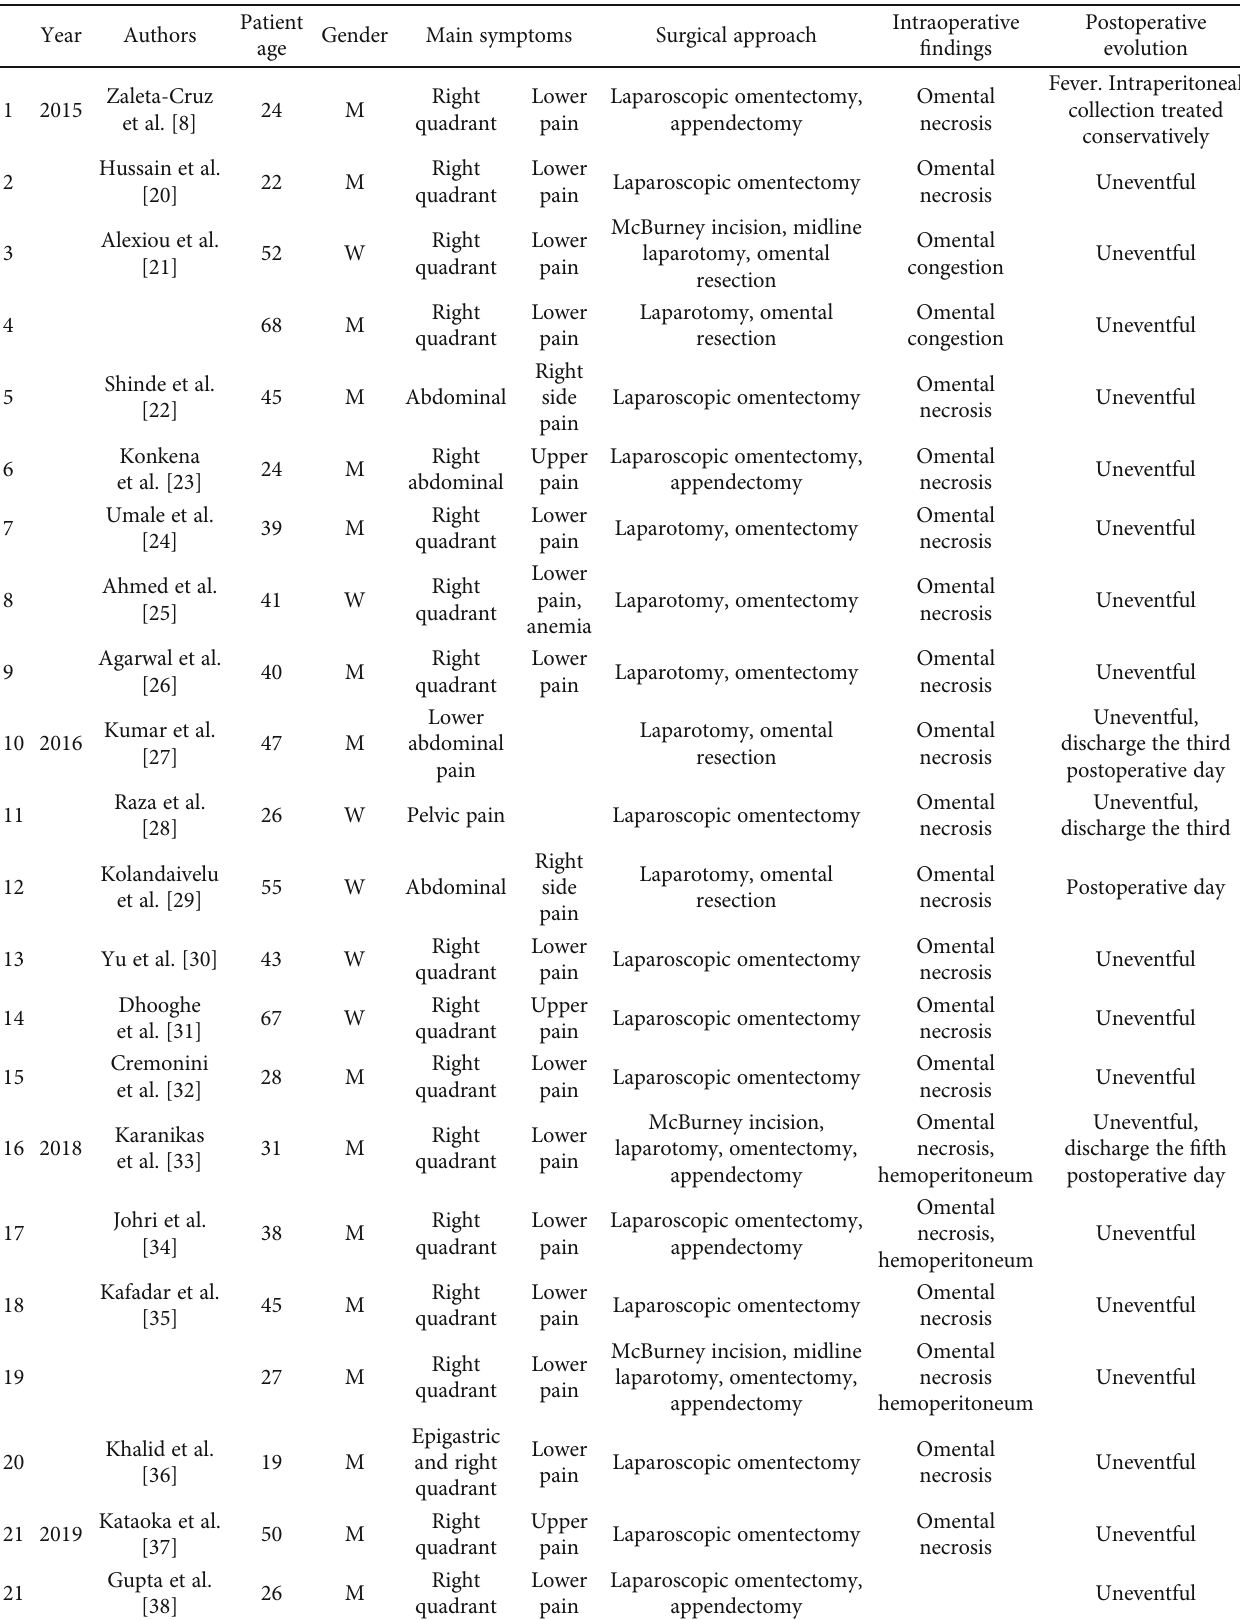
Table 1: Primary omental surgical approach between 2015 and 2020 — literature